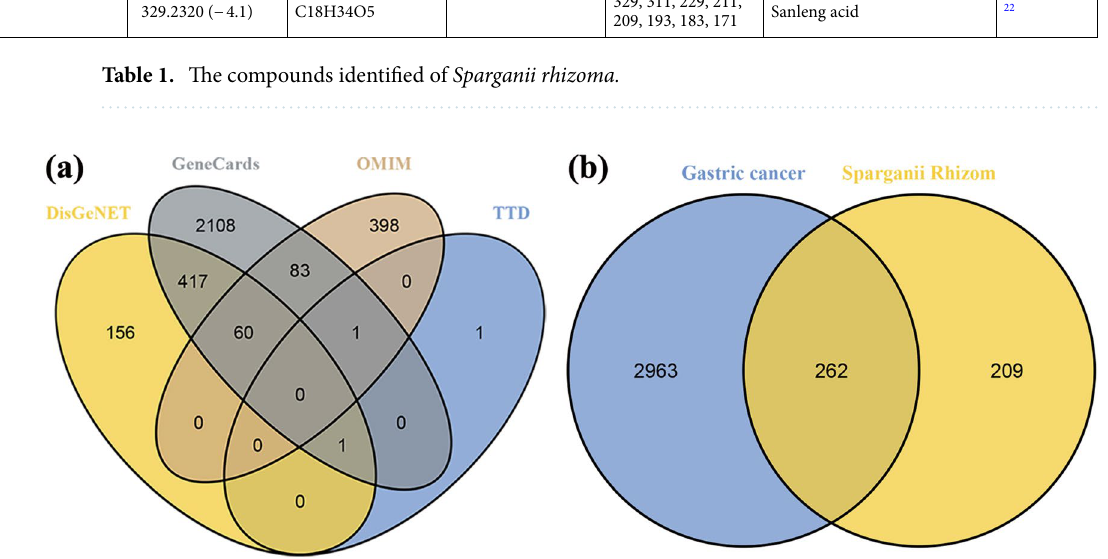
Figure 2. Target maps of Sparganii rhizoma and gastric cancer. ( a ) Gastric cancer targets in different disease databases. ( b ) Venn diagram of Sparganii rhizoma and gastric cancer